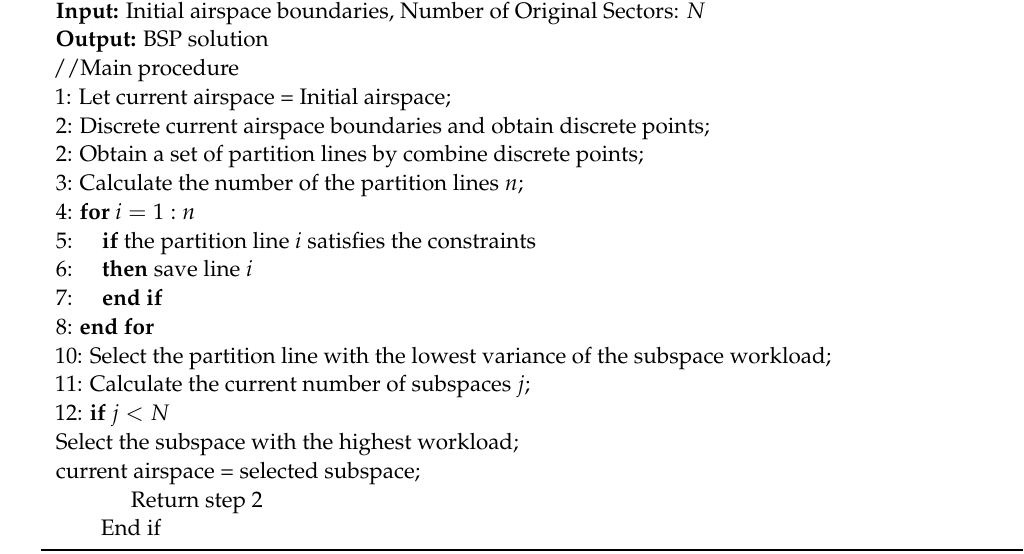
Algorithm 1: BSP algorithm